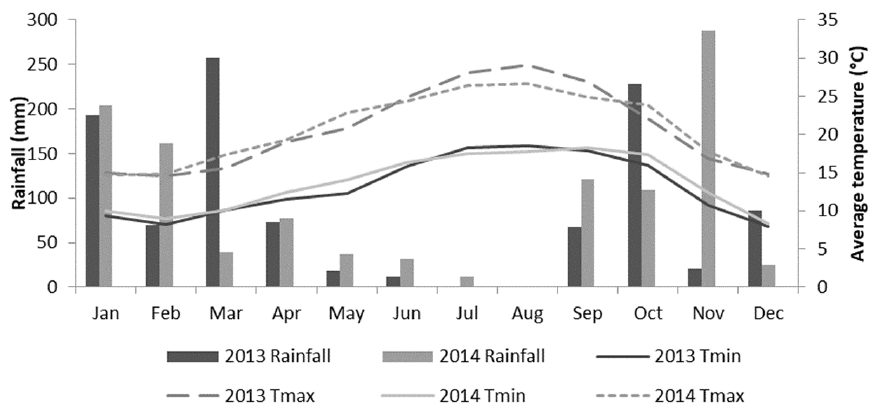
Figure 1. Climatic conditions (Tmin, Tmax, and rainfall) in 2013 and 2014 in Sintra, Portugal. During the first months of the vegetative cycle (May and June), the Tmin and Tmax were higher in 2014 (variation between 14.0−26.6 °C) than in 2013 (variation between 12.3−29.1 °C). Later in the